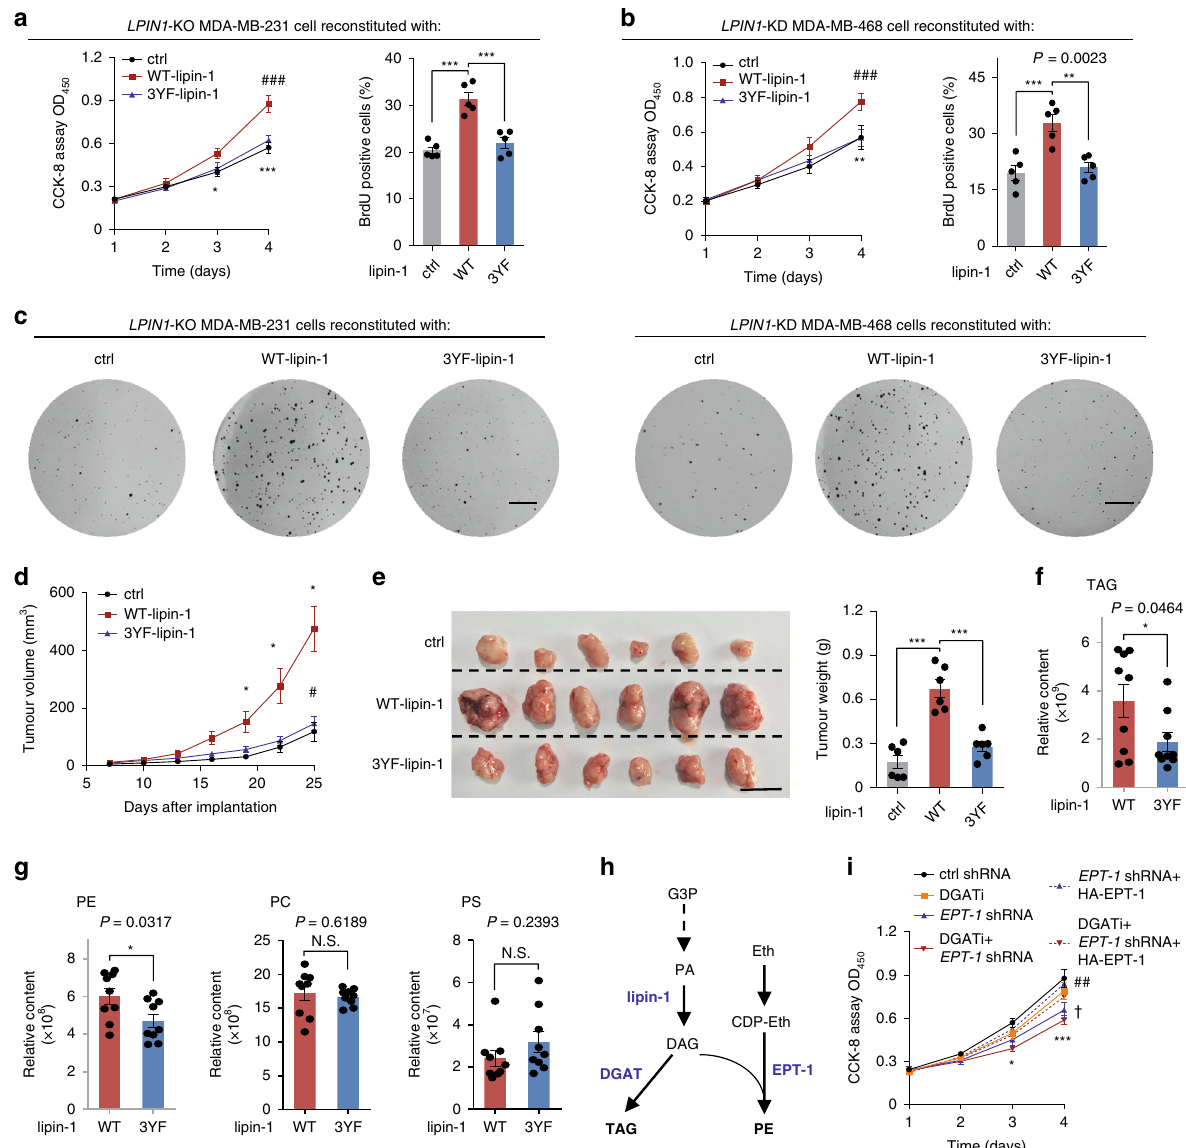
Fig. 3 The proliferation of breast cancer cells depends on the tyrosine phosphorylation of lipin-1. a , b Re-expression of WT-lipin-1 but not 3YF-lipin-1 restored the proliferation of breast cancer cells. LPIN1- KO MDA-MB-231 cells ( a ) or MDA-MB-468 cells knocked down of LPIN1 ( LPIN1 -KD) ( b ) infected with empty vector (ctrl), WT-lipin-1 or 3YF-lipin-1 and were maintained in complete medium containing 10% FBS. The CCK-8 assay ( n = 4 experiments) and BrdU incorporation assay ( n = 5 experiments) were performed to determine viable cell number. (Left graph of a ) ctrl versus WT-lipin-1, * P = 0.0168 (day 3), *** P < 0.001 (day 4); WT-lipin-1 versus 3YF-lipin-1, ### P < 0.001 (day 4). (Left graph of b ) ctrl versus WT-lipin-1, ** P = 0.0011 (day 4); WT-lipin-1 versus 3YF-lipin-1, ### P < 0.001 (day 4). c The soft agar colony formation assay was performed with LPIN1 -KO MDA-MB-231 cells or LPIN1 -KD MDA-MB-468